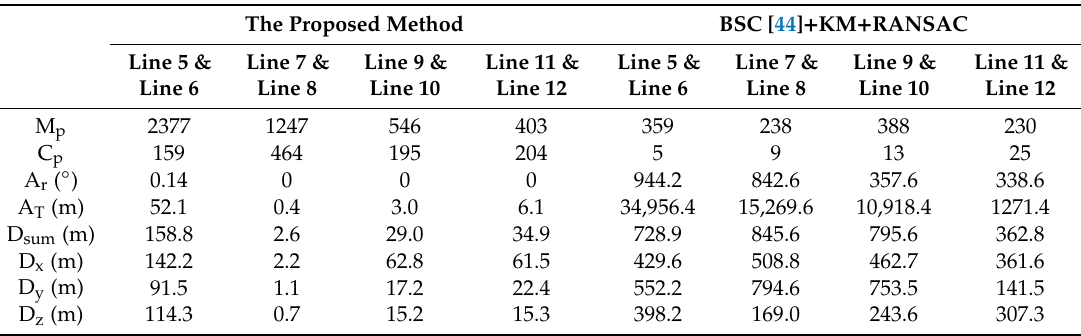
Table 7. Registration errors of four